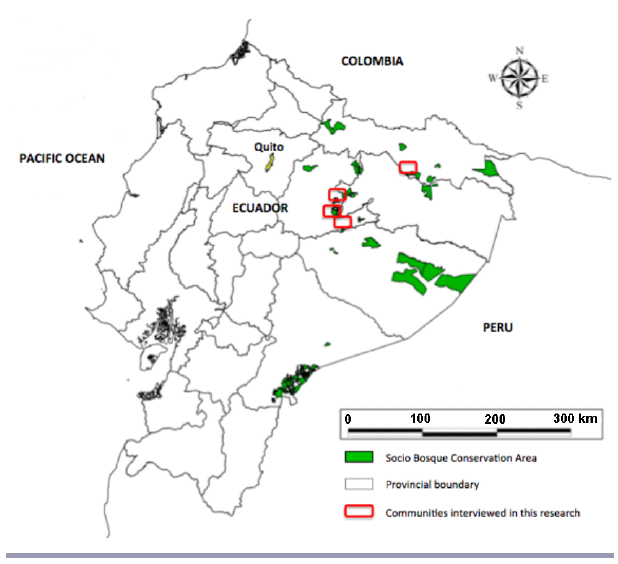
Fig. 1 . Geographic location of the four communities interviewed for this research (red boxes) participating in the forest conservation scheme Programa Socio Bosque in the Ecuadorian provinces of Napo (left) and Sucumbíos (right).